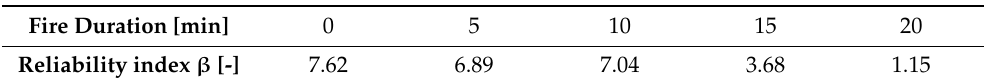
Table 3. The results of reliability analysis of the two degrees of freedom structure in the following minutes of fire duration.